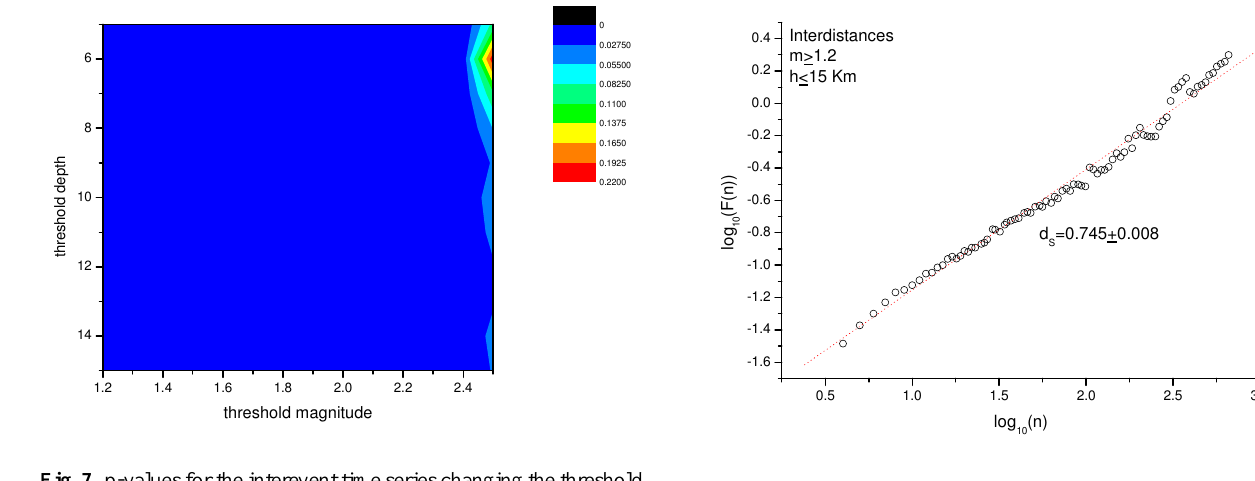
4 Discussion Time-clustering of a point process can be described by the increase of occurrence frequency of events in a relatively narrow time interval against the general low occurrence fre- quency over a longer time span. Accordingly, it is consid- ered as the opposite of temporal homogeneous